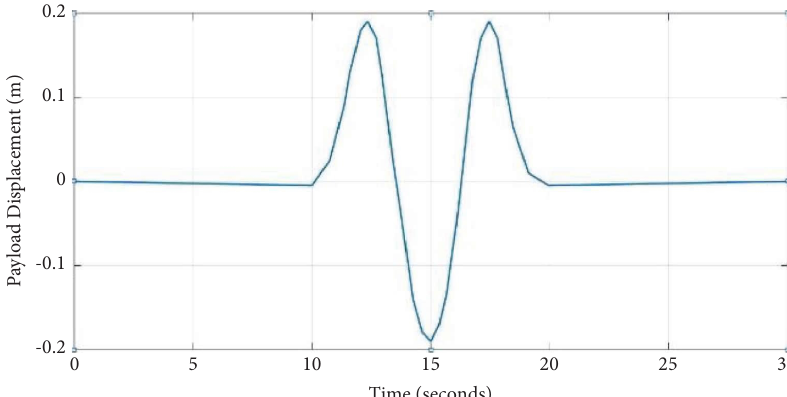
Figure 13: Te fourth input signal applied on the